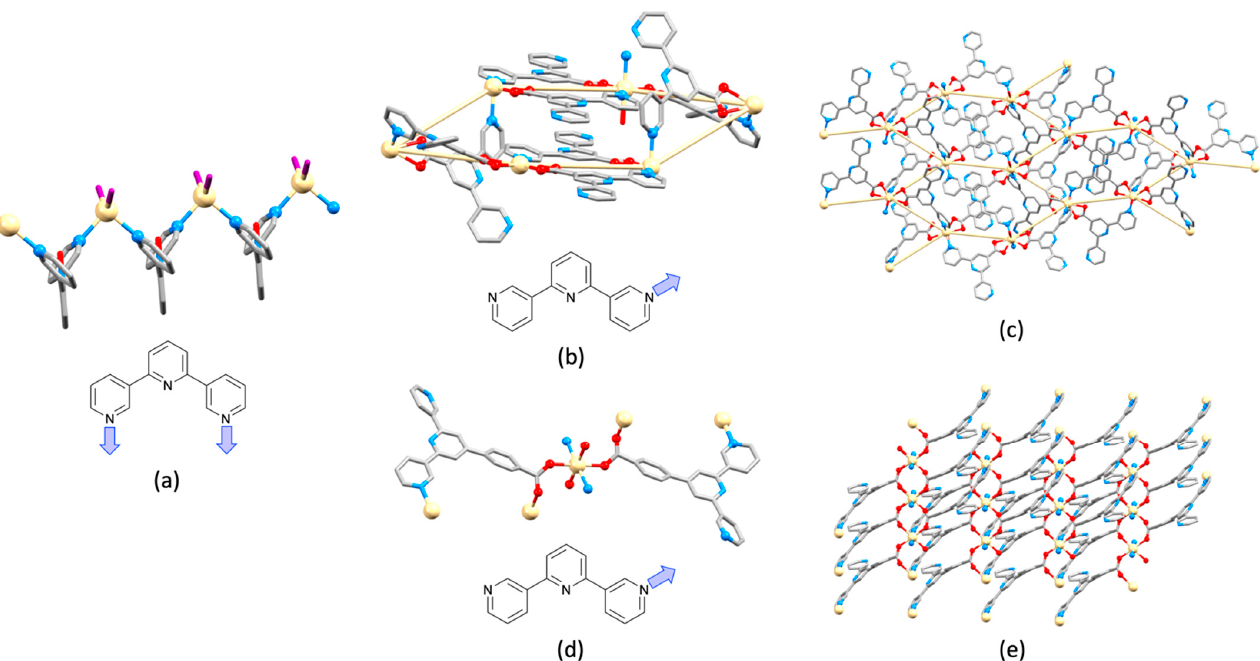
Figure 44. ( a ) Part of the 1D-polymer in [CdI 2 ( 66 )] n (CSD refcode HATFOA), and the limiting planar conformation. ( b ) Part of one 6-membered circuit in the (6,3) net in [Cd( 60 ) 2 (OH 2 )] n (refcode XEWGEN); there are two crystallographically independent 60 – ligands but both can be described by the same limiting planar conformation. ( c ) Part of the (6,3) net in [Cd( 60 ) 2 (OH 2 )] n . ( d ) The 6-connecting Cd(II) and 3-connecting ligand nodes in [Cd( 61 ) 2 ] n with a schematic diagram of the planar conformation of the 3,2 (cid:48) :6 (cid:48) ,3 (cid:48)(cid:48) -tpy, and ( e ) part of the 2D-network in [Cd( 61 ) 2 ] n (refcode DOGFEN) viewed down the c ‐ axis.